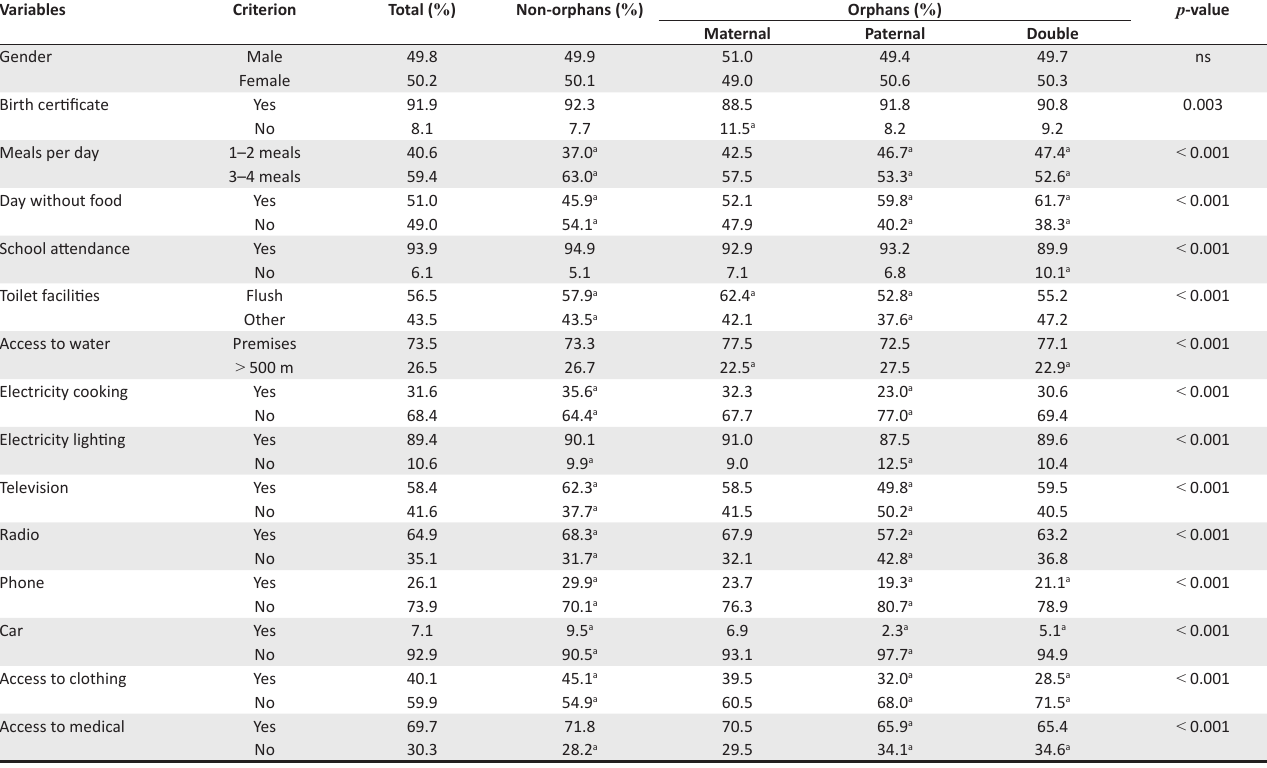
TABLE 3: Difference between non-orphans, maternal, paternal and double orphans on key criteria of vulnerability in Kanana, Botswana. Variables